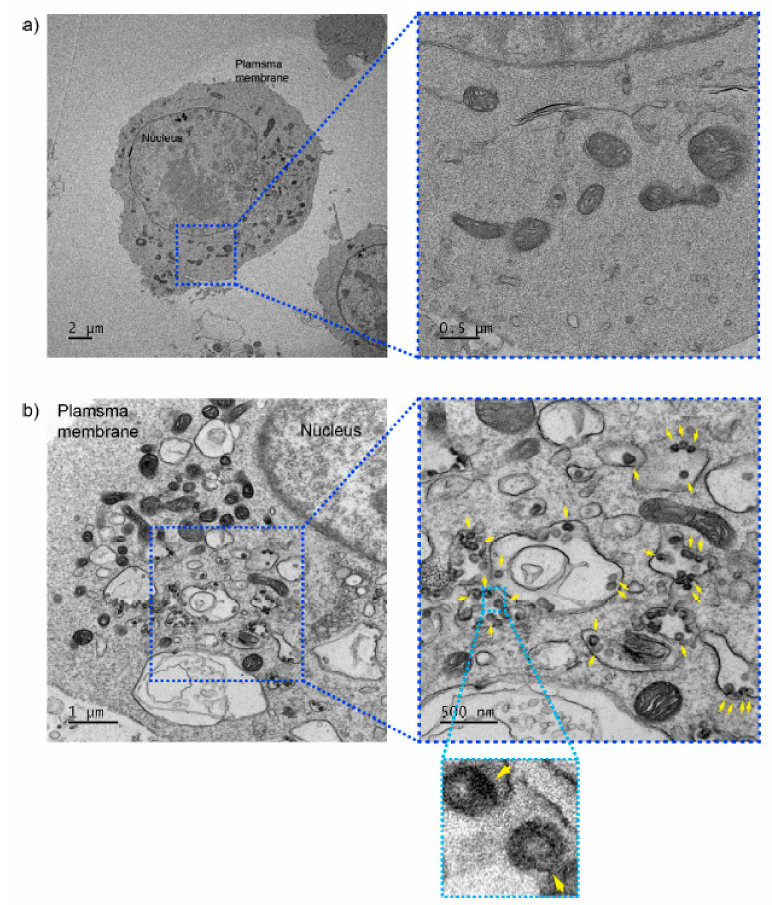
Figure 5. In-cell self-assembly of R 12 –FKFEFKFEFKFE peptide (R 12 - β UNS). Transmission electron micrographs of N2a neuroblastoma cells demonstrating reverse self-assembled nanostructure in the subcellular organelles. ( a ) Cells without incubation with the peptides. ( b ) Cells incubated with the peptides. Arrows indicate vesicle formed in the subcellular organelles. Reprinted with permission from